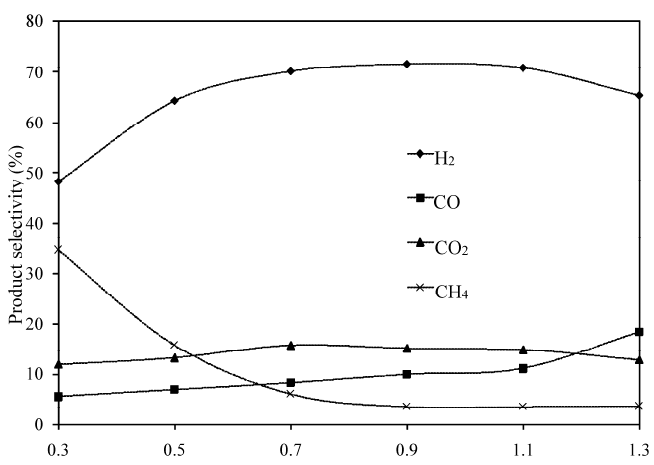
Figure 8. Effect of steam/carbon (S/C) molar ratios on product selectivity over 18 wt. % Ni 0.5 ‐ Cu 0.5 / γ‐ Al 2 O 3 catalysts at 550 °C, N 2 = 15 cm 3 /min; iso ‐ octane feed rate was 0.03 g/min (SV = 1.21 h − 1 ).